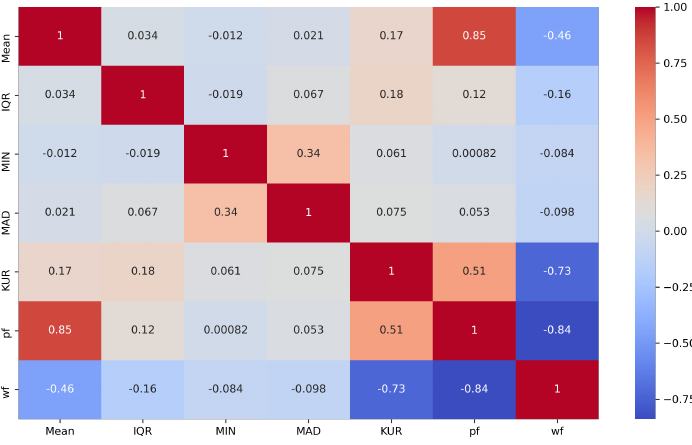
Figure 14. Feature extraction plot for the Dissipation factor dataset.